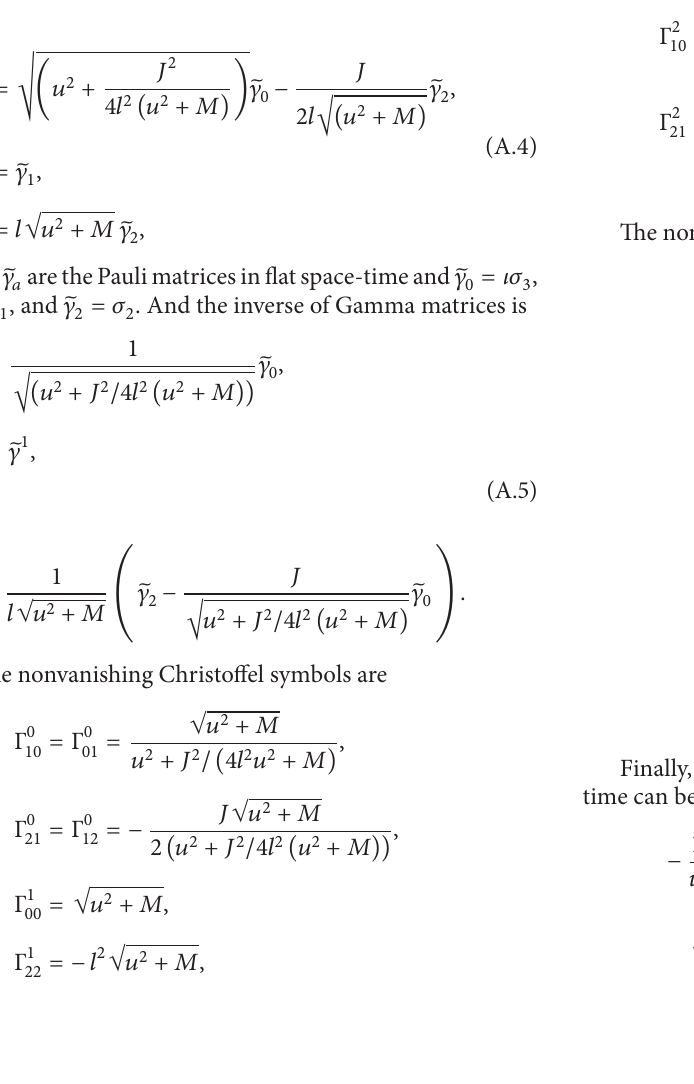
and 𝑐 − are the function of 𝜇 with different masses. The coefficient 𝑐 1 1